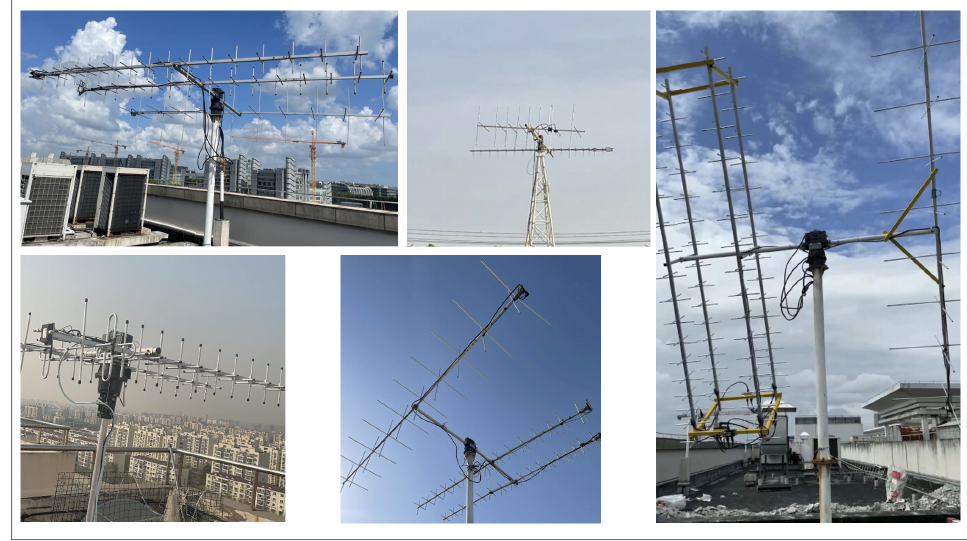
Figure 15. RF frontend flow.